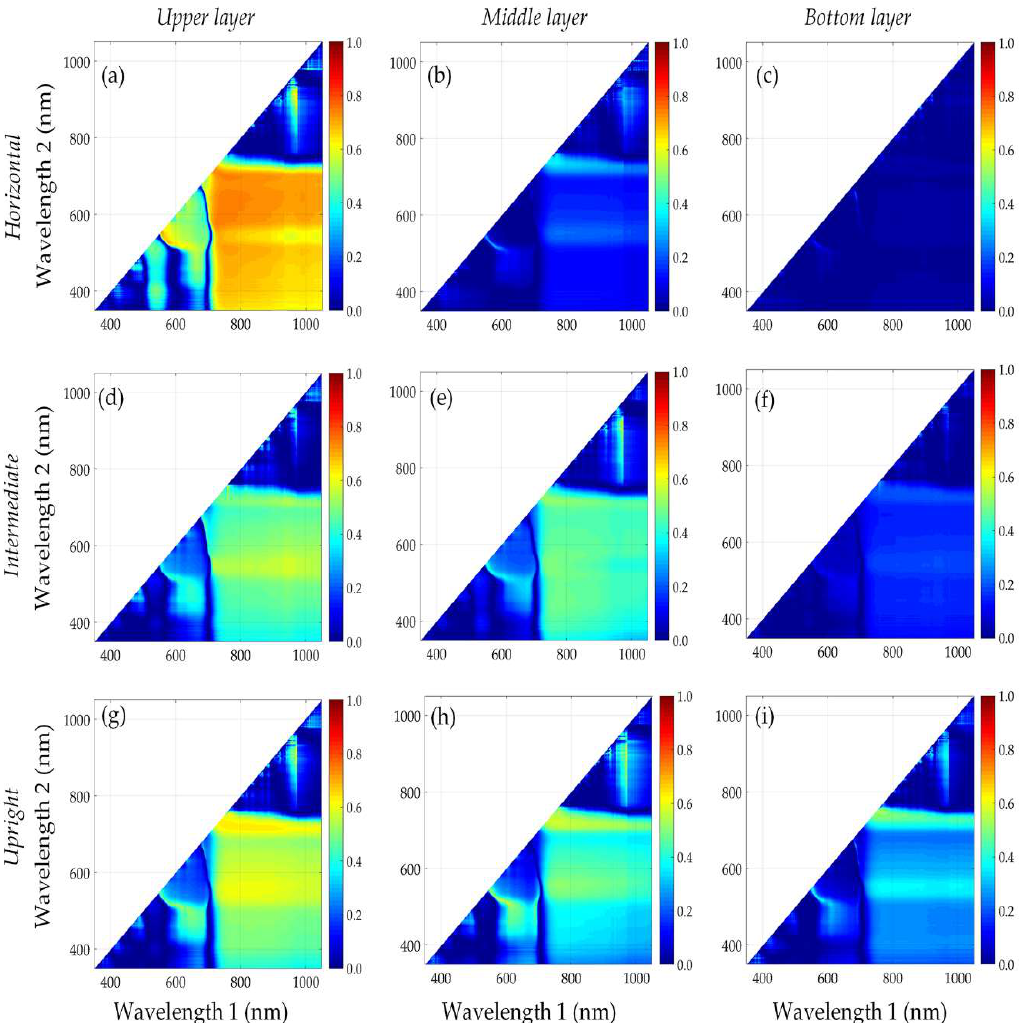
Figure 2. Maps showing the coefficients of determination ( R 2 ) for the relationships between the leaf N density and SR index calculated from all possible 2-band combinations in the range of 35–1050 nm across all stages. ( a ) The upper layer of horizontal leaf varieties, ( b ) the middle layer of the horizontal leaf varieties, ( c ) the bottom layer of the horizontal leaf varieties, ( d ) the upper layer of the intermediate leaf varieties, ( e ) the middle layer of the intermediate leaf varieties, ( f ) the bottom layer of the intermediate leaf varieties, ( g ) the upper layer of the upright leaf varieties, ( h ) the middle layer of the upright leaf varieties, and ( i ) the bottom layer of the upright leaf varieties.